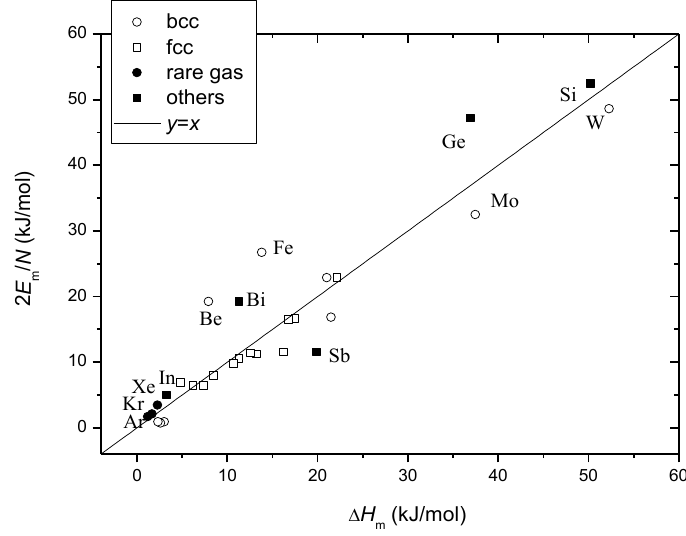
Figure 3. Coincidence of the calculated and measured latent heat of melting for Si, Ge, Bi, Sb, In (filled squares) and Ar, Kr, Xe (filled circles) as complied in Table 1. Data reported in [29] were also shown for reference (open circles and squares).